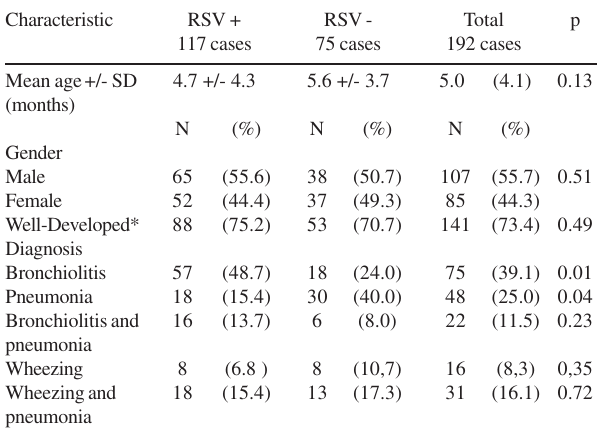
Table 1 - Demographic characteristics and diagnosis status of the RSV positive and negative